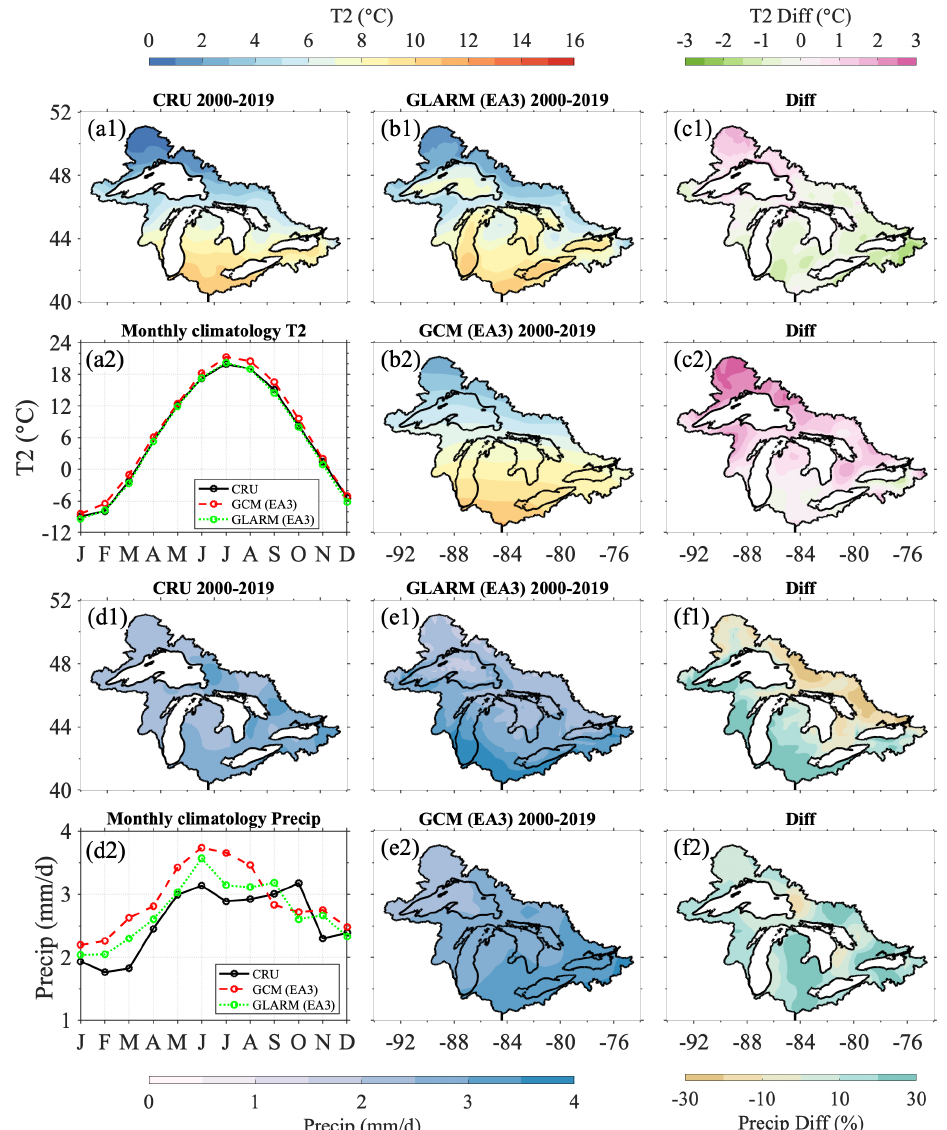
Figure 3. Climatology of surface air temperature (a1–c2) and precipitation (d1–f2) over the Great Lakes basin (2000–2019) from the GLARM-EA3 simulation and GCM-EA3 simulation and their biases (model minus observations) relative to CRU land-based observations. Panels (a2) and (d2) show the monthly climatology of surface air temperature and precipitation over the land,